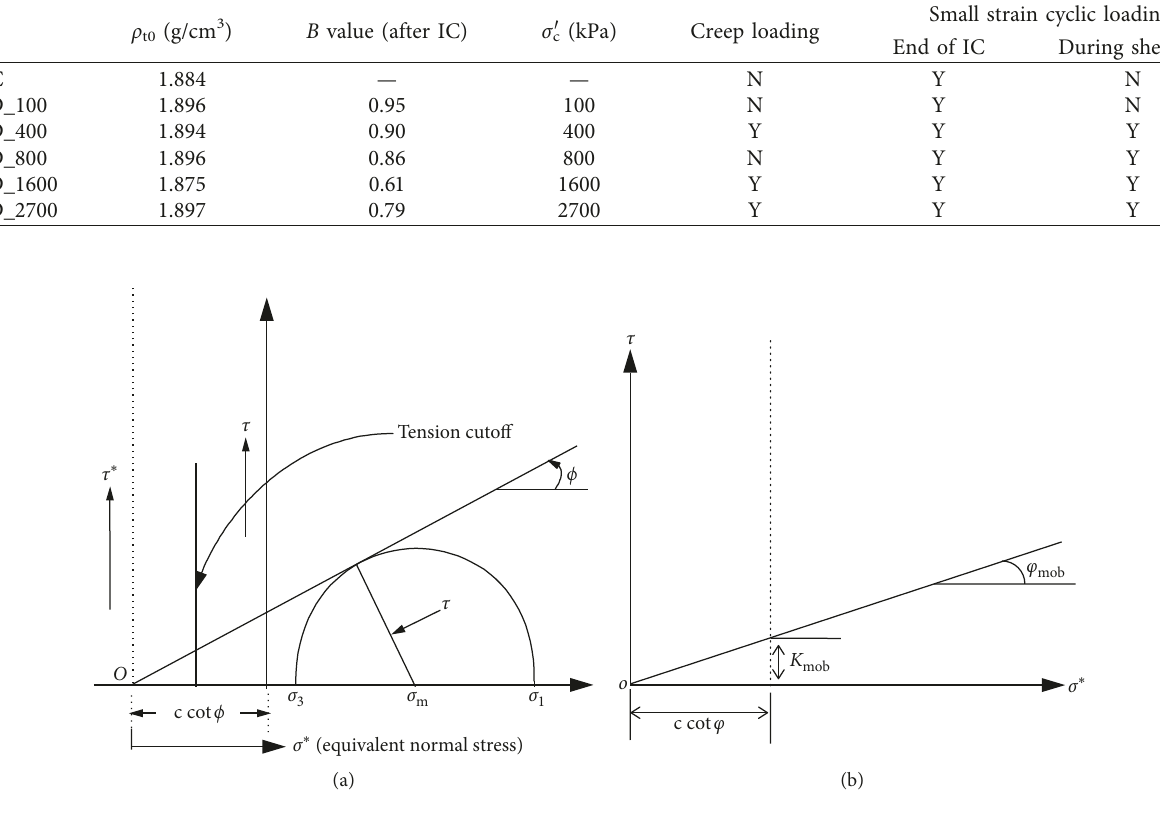
Figure 3: Schematic diagram of failure criterion of a cohesive frictional hardening